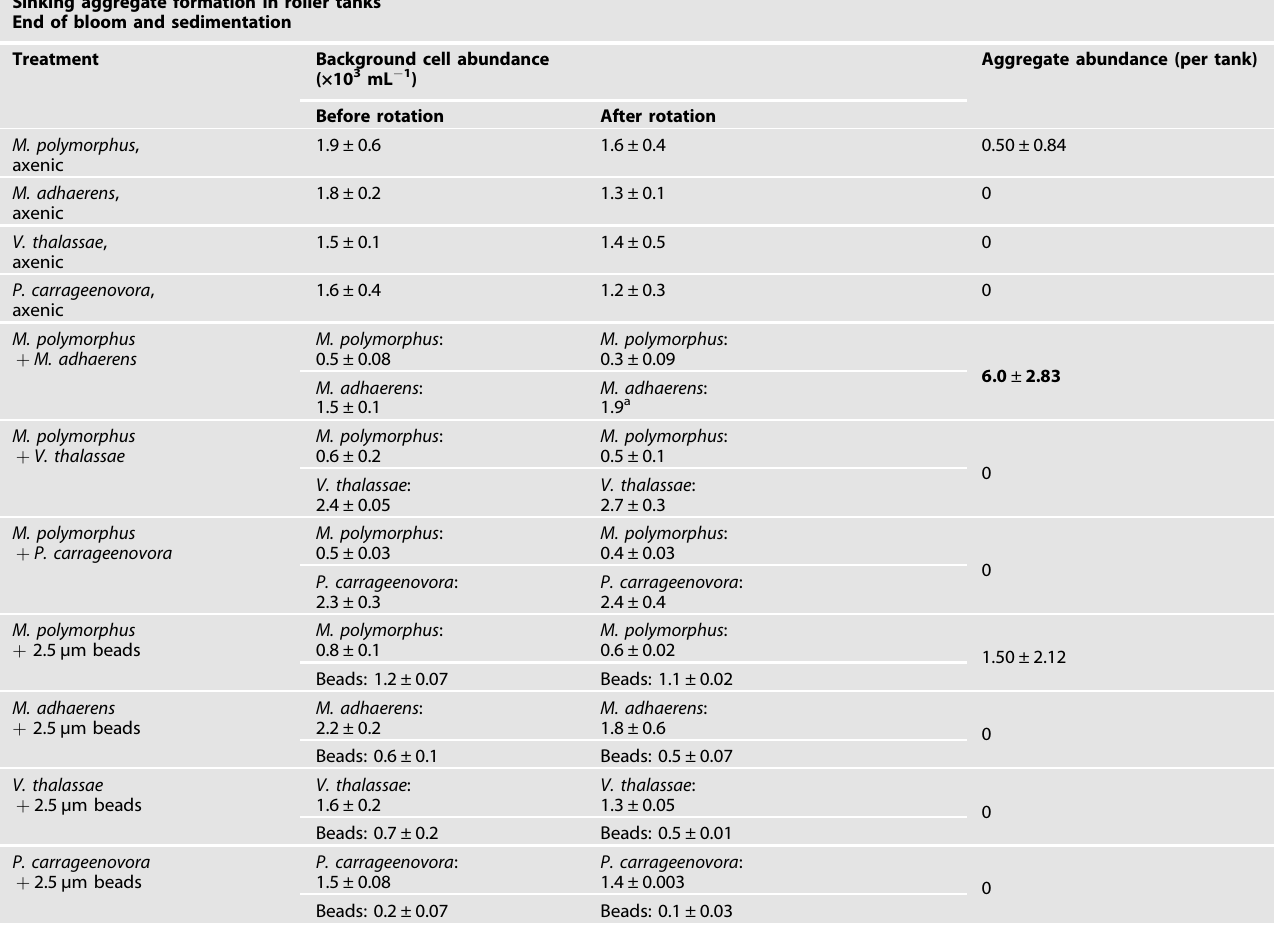
Table 3. Abundance of aggregates formed in roller tank experiments inoculated to lower total cell abundances (10 3 cells mL − 1 ). Sinking aggregate formation in roller tanks End of bloom and sedimentation Treatment